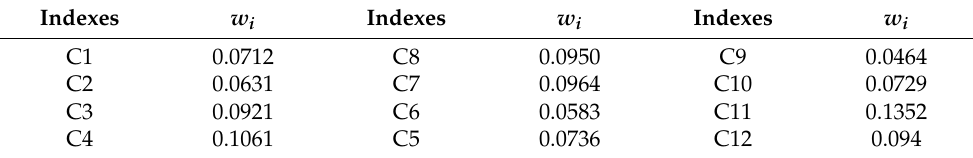
Table 5. Combination weight of AHP and